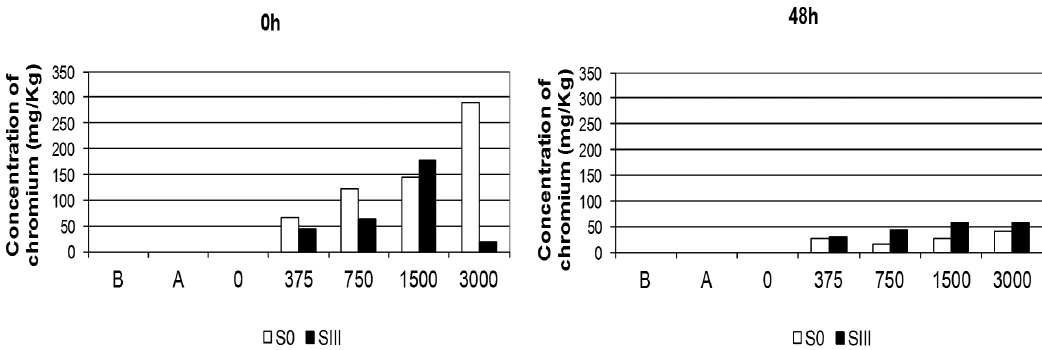
Figure 5. Chromium concentration in the sediment at the beginning (0h) and end (48h) of the tests with artificial sediment in D. rerio and P. reticulata with (SIII) and without organic matter (S0). A: treatment with sand without contamination by chromium; B: Blank (reconstituted water).